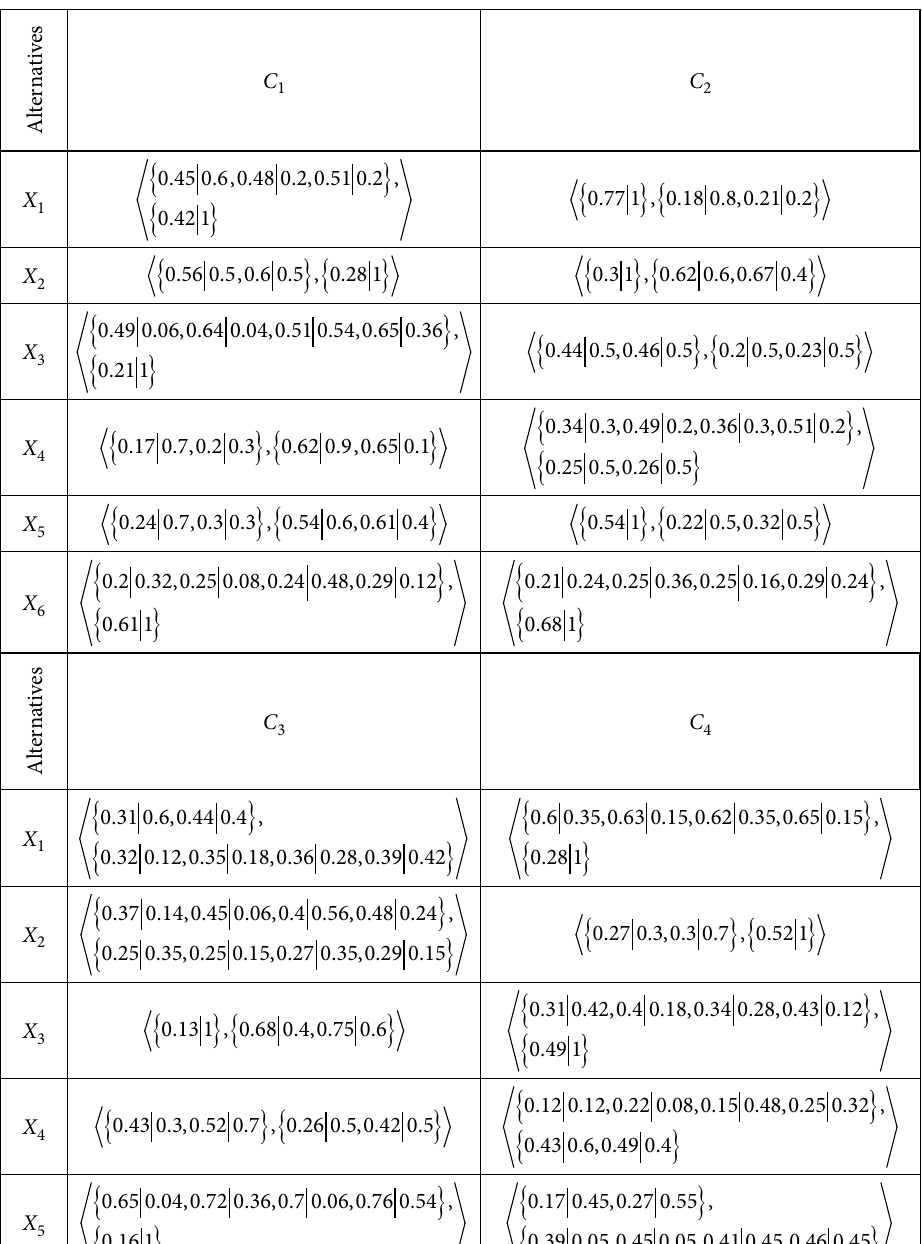
Table 4. The final collective decision-making information